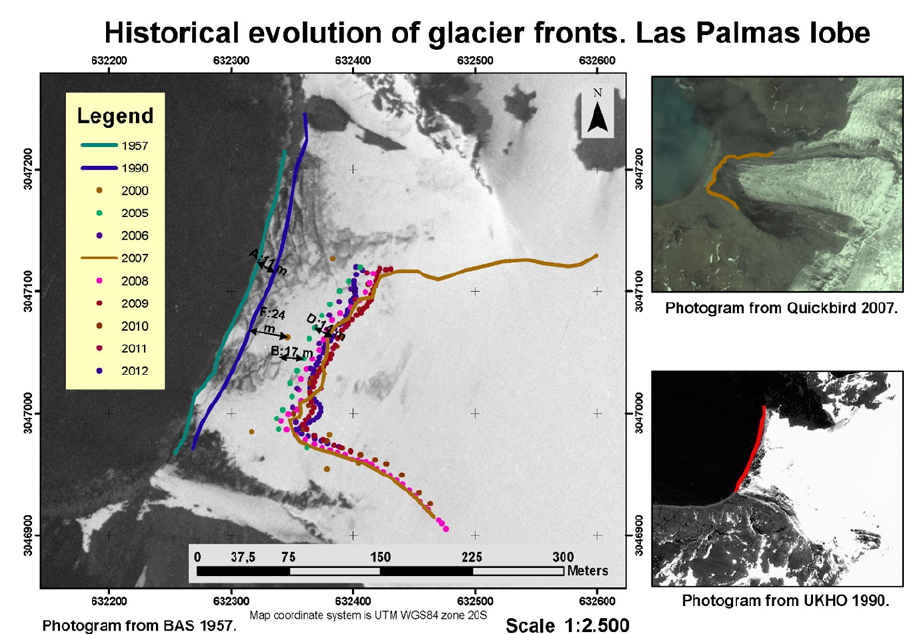
Figure 11. Terminus position changes of the front of Las Palmas side lobe of Hurd Glacier. The oldest front position available corresponds to 1957 (in green) and the latest to 2012 (blue points). The base map corresponds to the BAS aerial photograph of 1957. The scale bar shown in the figure does not match with the map scale